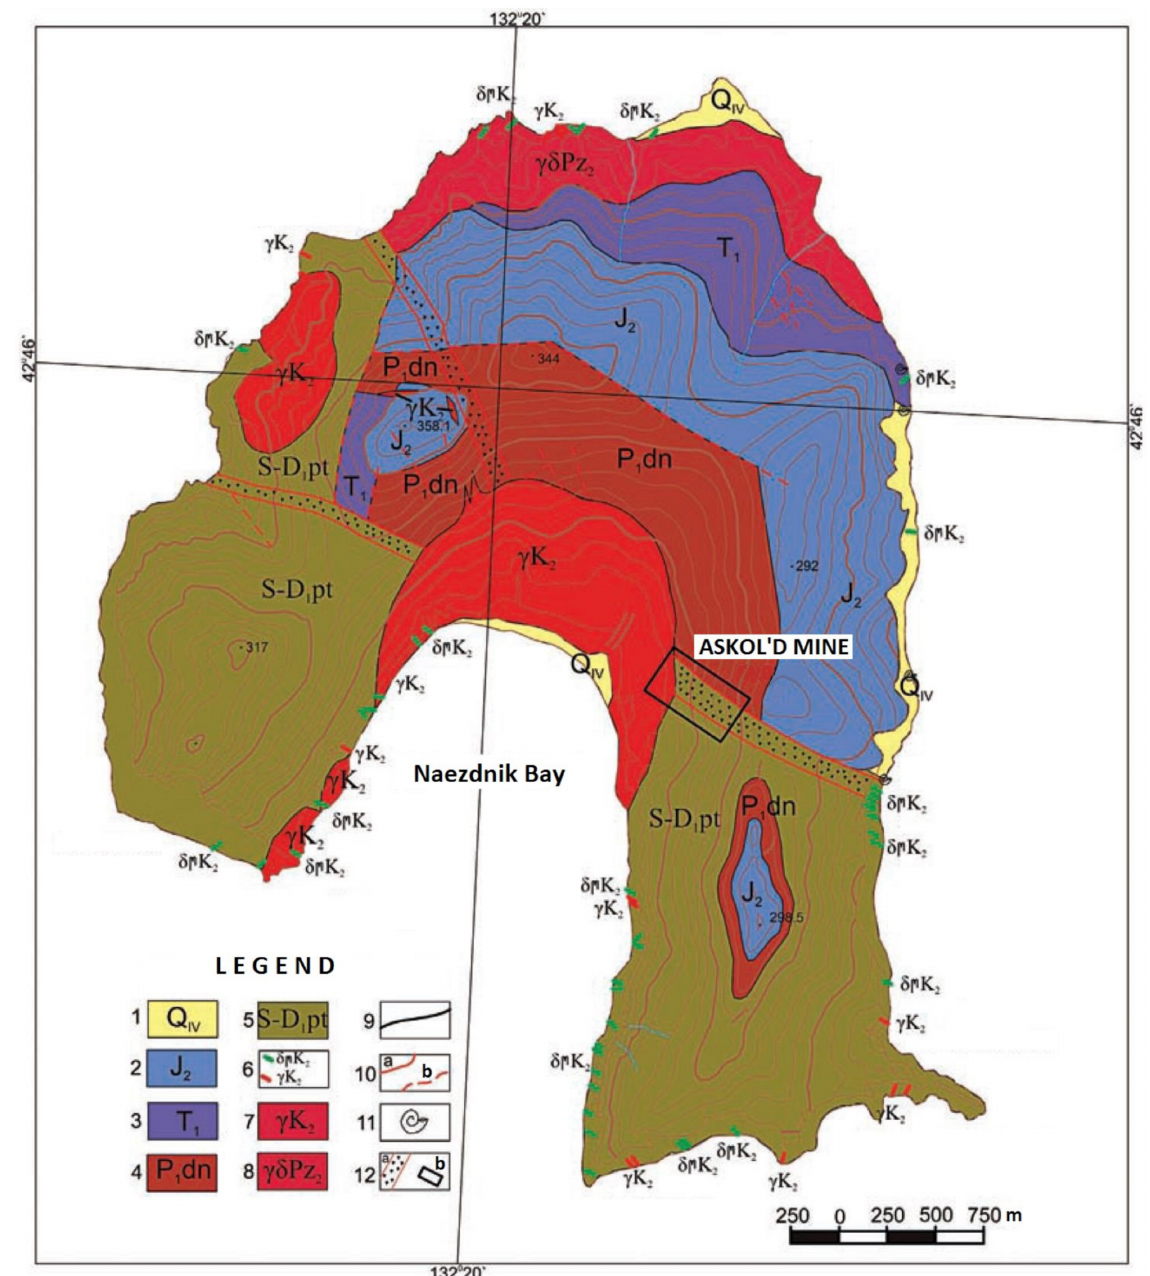
Figure 9. Geological map of the Askol’d Island (after [41]). 1—soft sediments; 2—Middle Jurassic sandstones and mudstones; 3—Lower Triassic conglomerates and sandstones; 4—Lower Permian quartz porphyry; 5—Silurian–Devonian metamorphosed conglomerates, biotite hornfelses, and meta- effusives; 6—Cretaceous dikes of diorite ( δµ K2), granite and aplite veins ( γ K2); 7—Cretaceous biotite- hornblende adakiticgranitoides and plagiogranites; 8—Middle Paleozoic granodiorites, diorites, gabbro-diorites; 9—geological boundaries; 10—faults proven (a) and supposed (b); 11—findings of fossil fauna; 12—ore-bearing tectonic zones (a) and the site of old mines